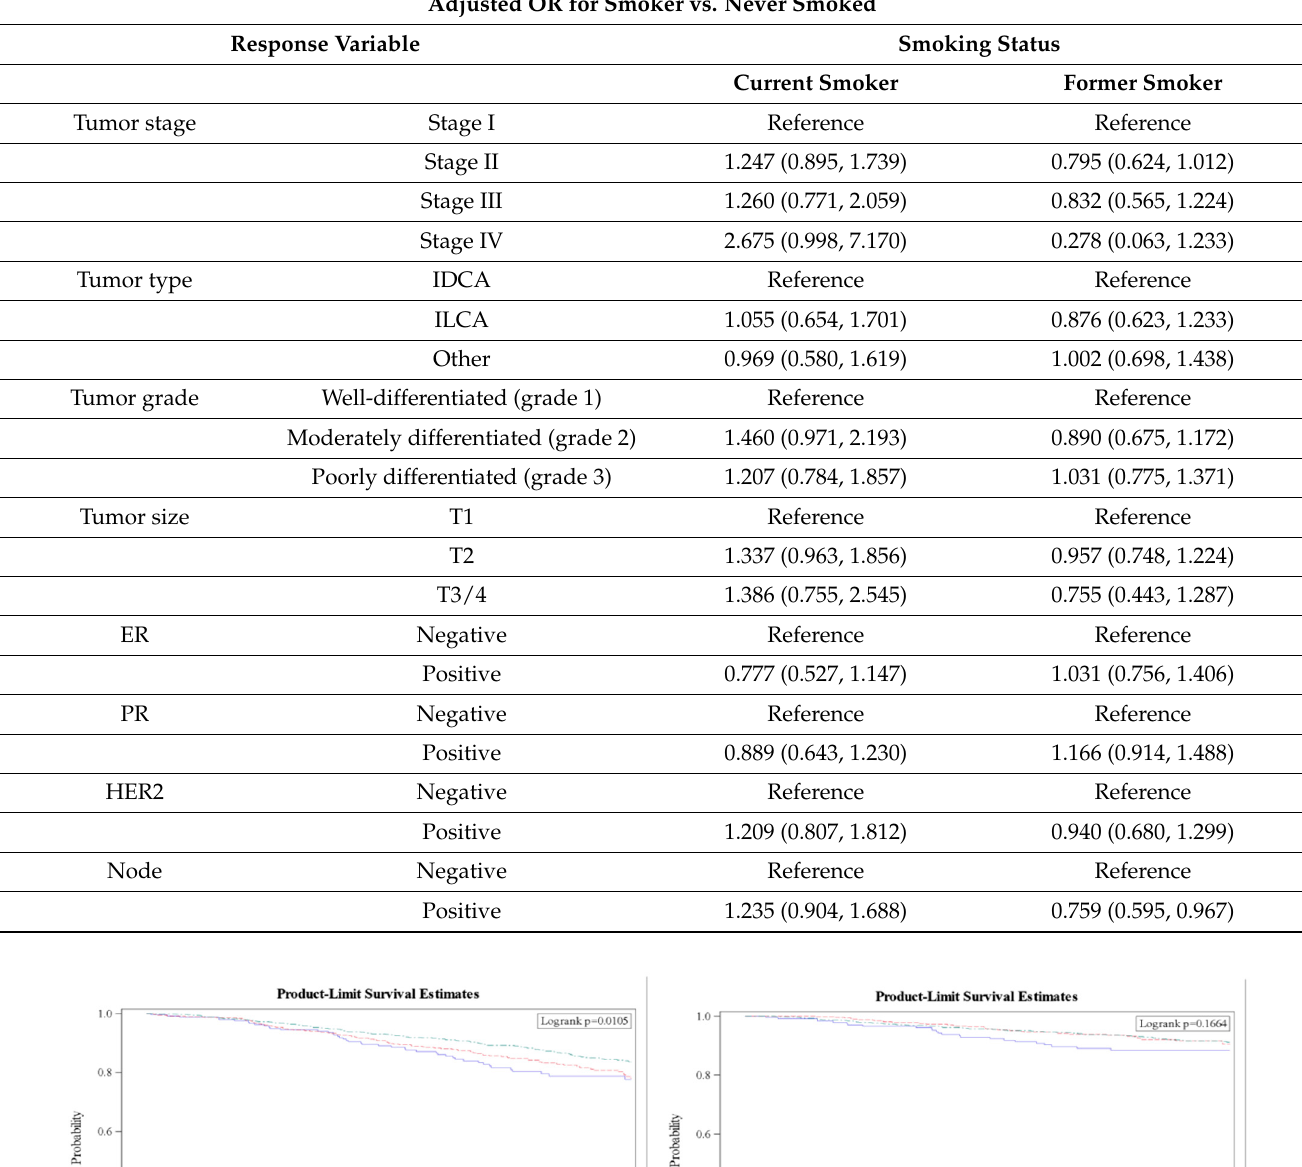
Table 3. Logistic regression model adjusted for age, race, marital status, education levels, site of enrollment, BMI, and CCI for women diagnosed with invasive breast cancer 2001–2016.